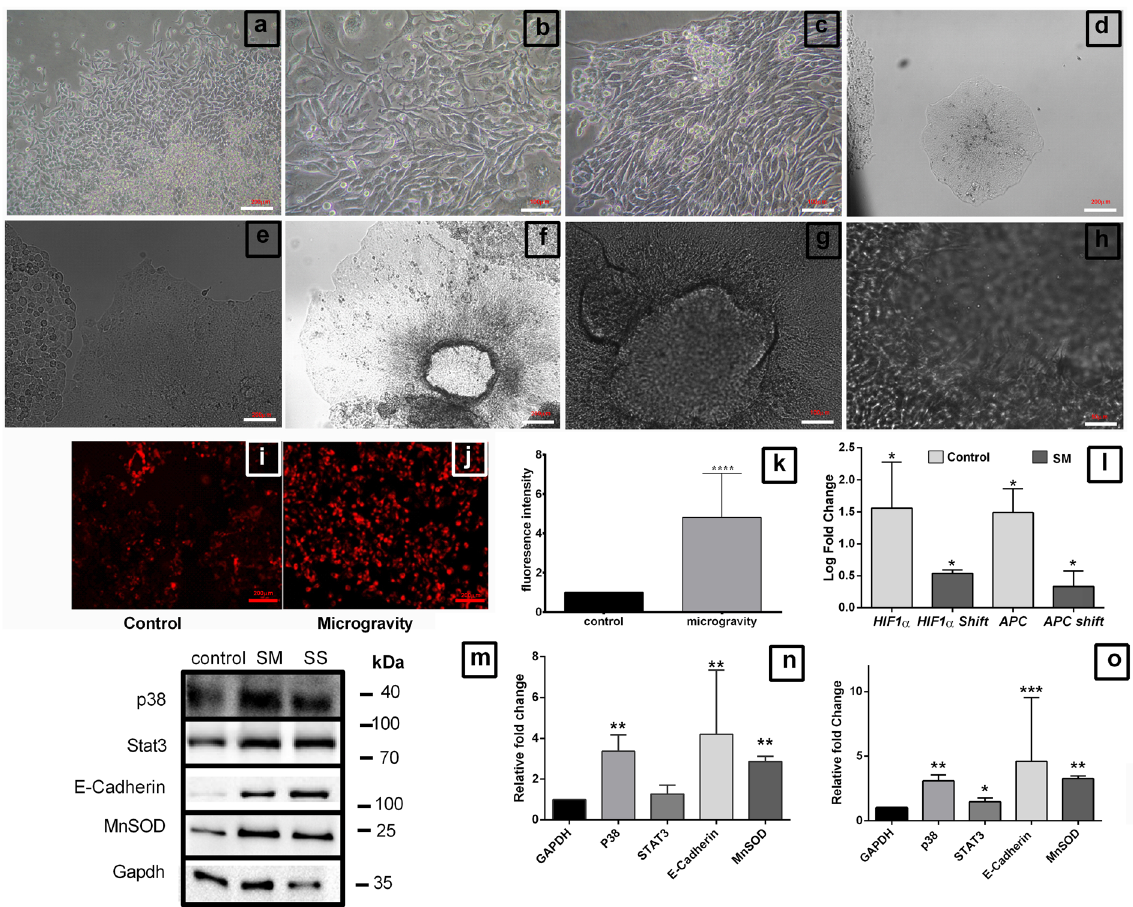
Figure 5. Adaptive responses of DLD1 to SM through differentiation. The morphogenetic effects of SM induced cell clumping, when clumps were shifted to normal culture conditions (( a – c ) 2 weeks, ( d , e ) 4 weeks, ( f – h ) 2 months). The DLD1 cell clumps from SM, when shifted to normal conditions adhered to plate and formed colonies (scale = 200 μ m) ( a ) which in two weeks, housed large and multinucleated cells, also cell-cell communication was profound with cell linkages (scale = 100 μ m) ( b ) also some of the cells were polarized directionally (scale = 100 μ m) ( c ). On prolonged culture for up to 2 months the specific features from the niche were more evident, some cells seems to retain the 3D conditioning and form rare, tightly packed colonies by 4 weeks ( d ) (scale = 200 μ m), ( e ) (scale = 100 μ m) which allows the cells to grow in a 3D fashion, forming cylindrical structures ( f ) (scale = 200 μ m), these cells continuously aggregate and form large spheroid like formations ( g ) (scale = 100 μ m) with formation of complex structures, facilitated through appendages ( h ) (scale = 50 μ m). Mitotracker-red imaging showing the increased membrane potential in microgravity (scale = 200 μ m) ( i , j ) and its graphical representation ( k ) P < 0.0005. Gene expression analysis of hypoxia related HIF1 α and APC (Adenamatosis Polyposis Coli) in SM and static Shift (SS) compared against GAPDH as control ( l ). Data represented as mean + S.D. Western blot for proteins involved in adaptive response STAT3, P38 MAPK, MnSOD and endothelial marker E-Cadherin in SM and Shift condition ( m ) and the representative graph compared relative to GAPDH for SM ( n ) and SS ( o ). Experiment was performed thrice and data represented as mean + S.D. * P < 0.05, ** P < 0.005, *** P < 0.001, statistical analysis done using Mann Whitney t